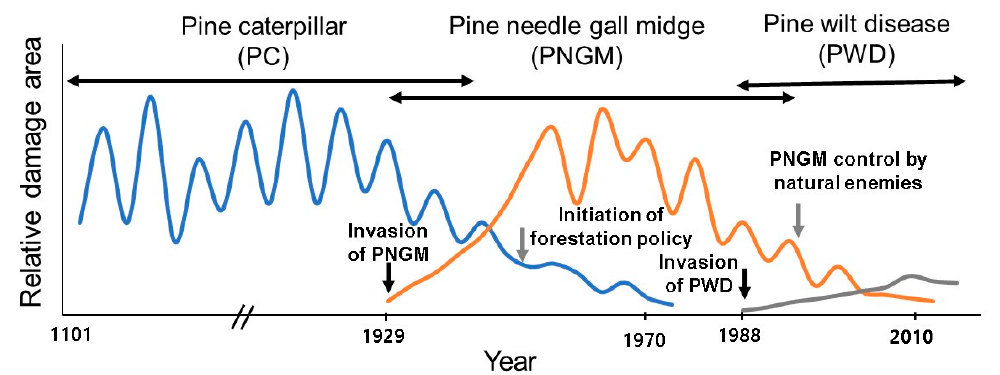
Figure 3. The schematic diagram for sequential changes in major pine forest pests in Korea from pine caterpillar via pine needle gall midge to pine wilt disease. The vertical black arrows indicate the first report of invasive species, and grey arrows indicate the potential causes of decline of pine caterpillar and pine needle gall midge. The first occurrence of pine caterpillar in Korea was reported in 1101 (Goryeo Dynasty) (http://www.history.go.kr).